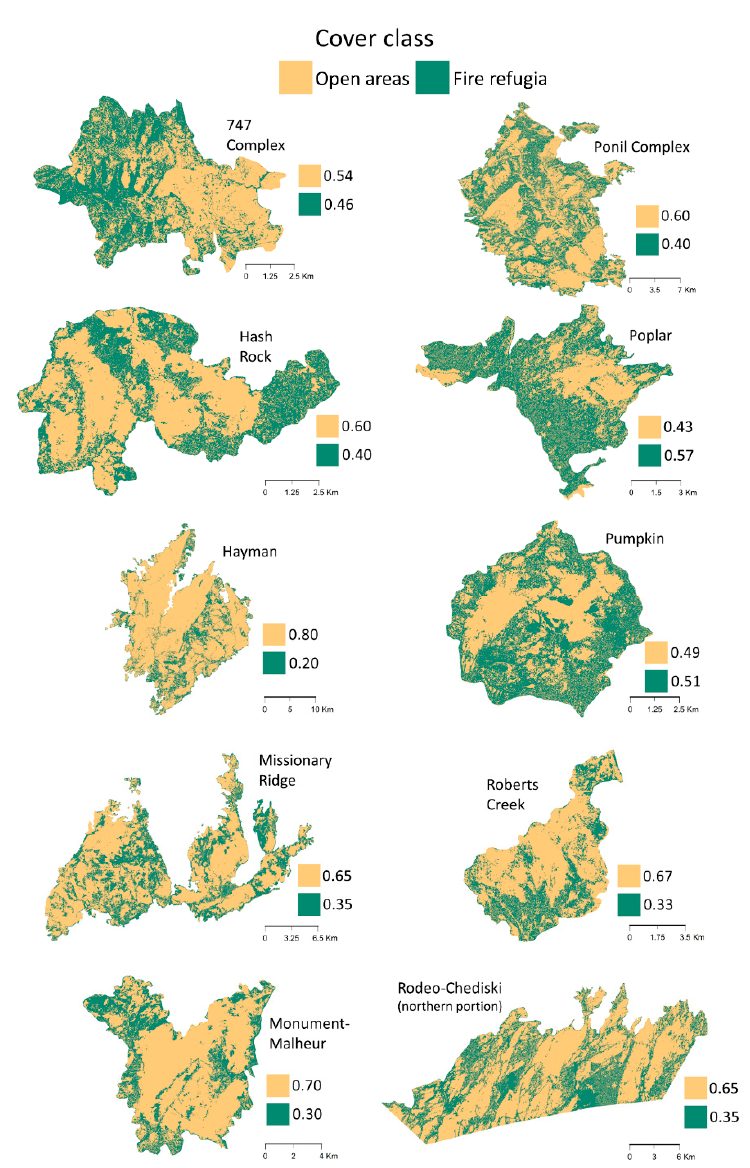
Figure 3. Fire refugia map for each fire and landscape proportions of each cover class. Note: map scale varies among burns.